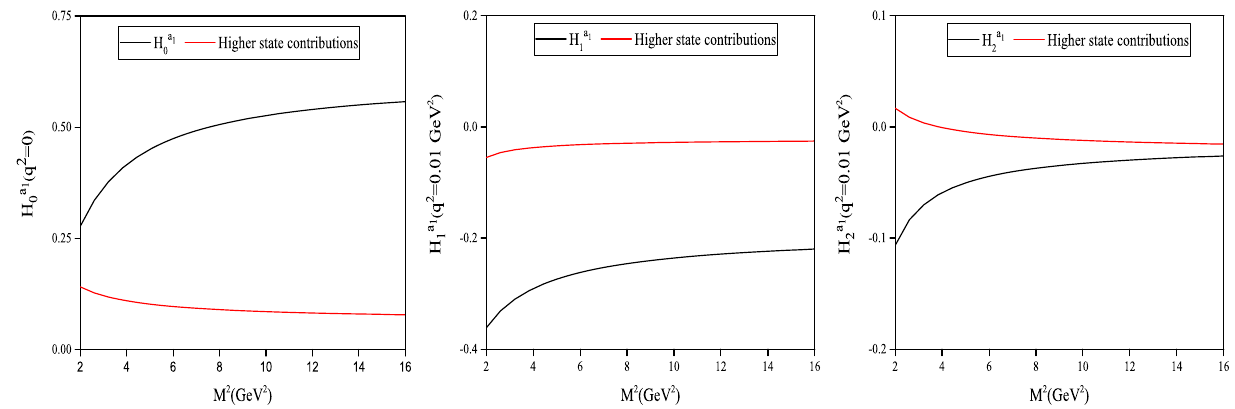
Fig. 3 D 0 → a − helicity form factors as a function of M 2 for s 0 = 7 GeV 2 as well as the higher states contributions in these form factors. The 1 values of q 2 are chosen as Fig. 1